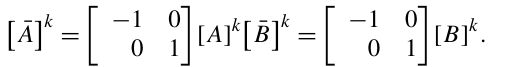
Figure 9. Stress Distribution at the Steel Tube ( P =